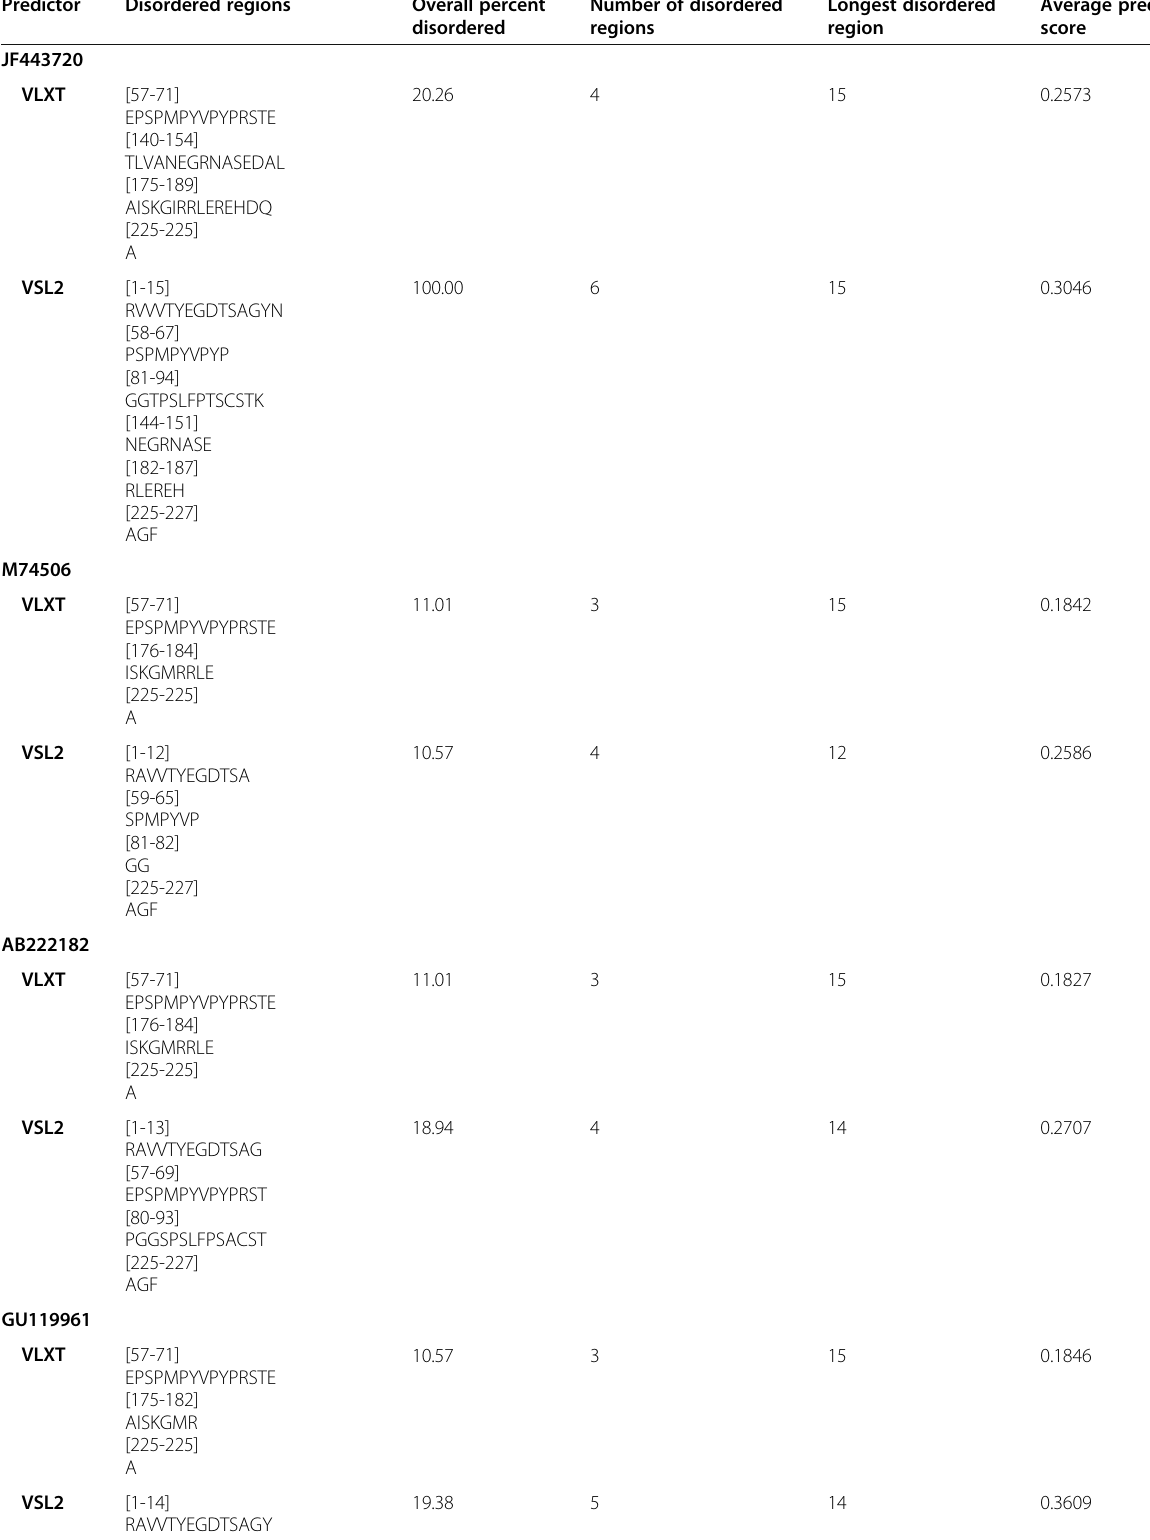
Table 2 The predicted percentage of intrinsic disorder scores of YDR in hepatitis E viruses